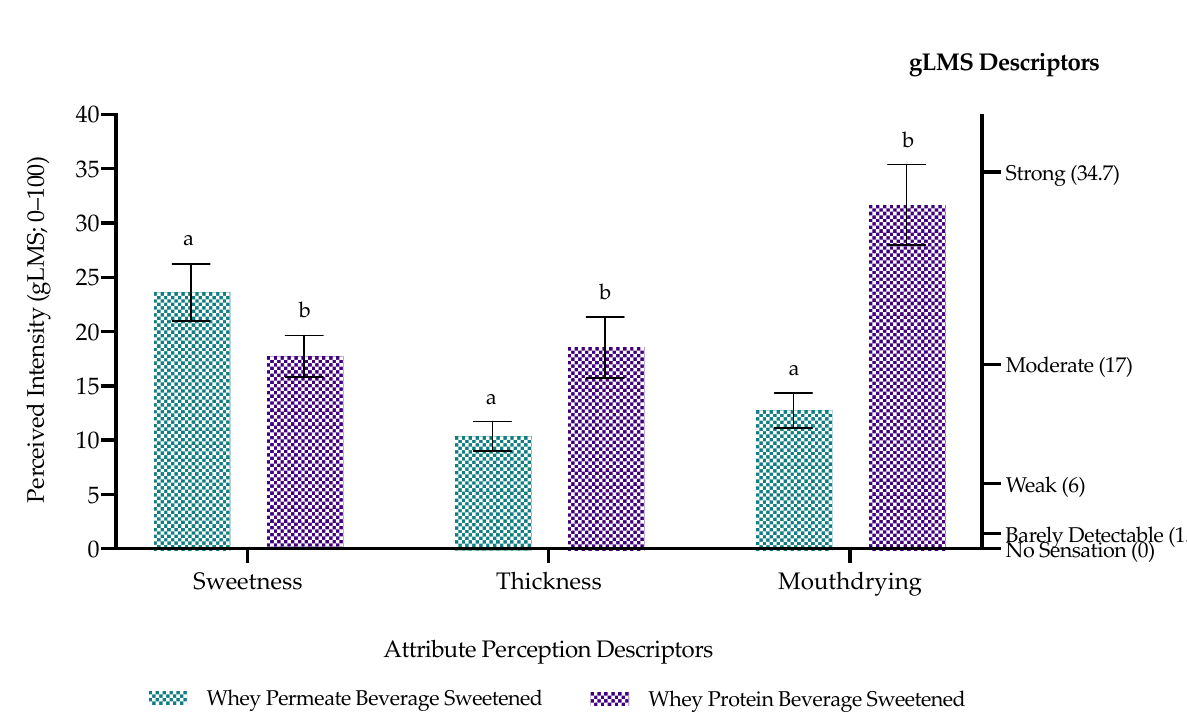
Figure 4. Volunteers’ attribute perception mean ratings (±standard error) of whey beverages ( n = 40; anti-logged data).